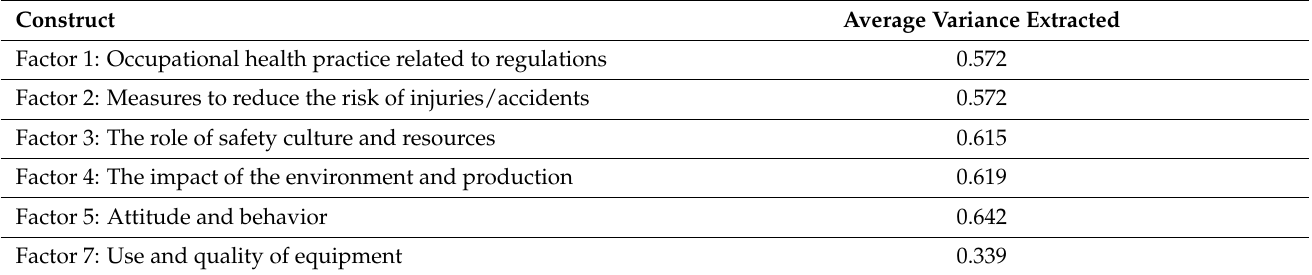
Table 3. Average Variance Extracted (AVE)